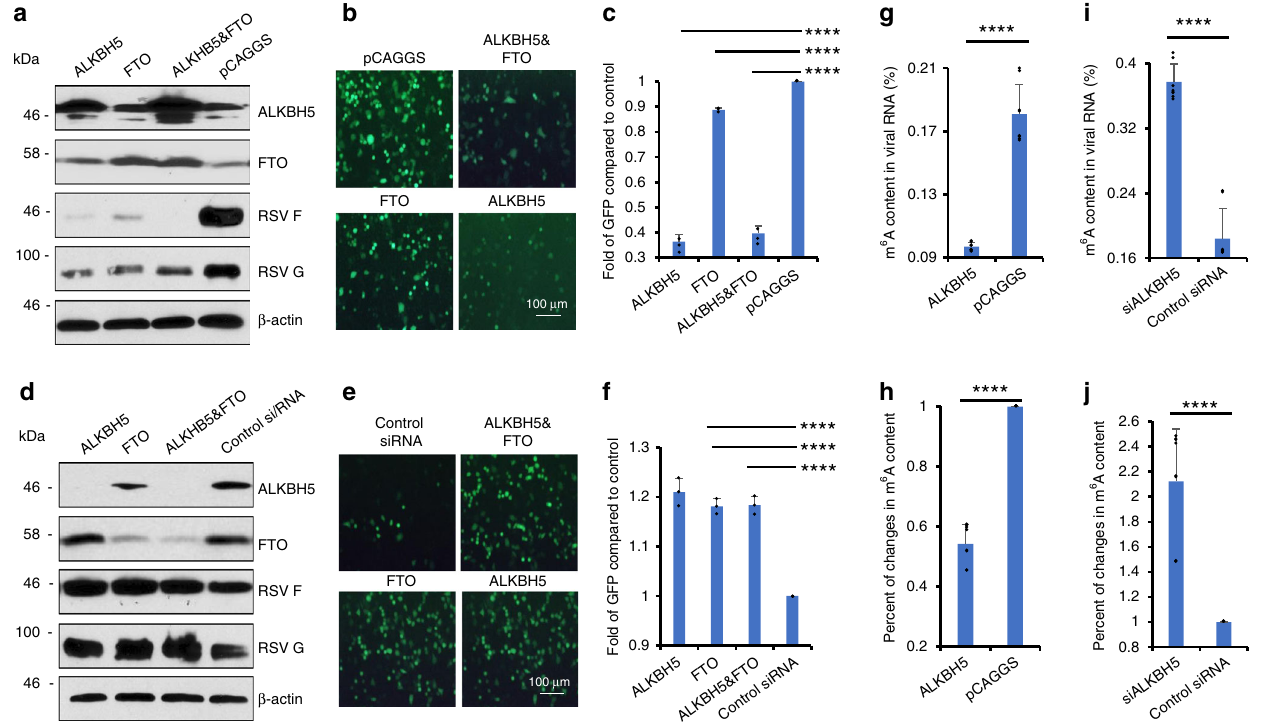
Fig. 5 Effects of m 6 A eraser proteins on RSV gene expression. a Overexpression of m 6 A eraser proteins diminishes RSV gene expression. HeLa cells were transfected with plasmids encoding ALKBH5 and/or FTO, followed by rgRSV infection at an MOI of 0.5. At 18 h post-infection, cell lysates were harvested for Western blot analysis. b Overexpression of m 6 A eraser proteins reduces GFP expression. The GFP expression was monitored by fl uorescence microscopy. Representative micrographs with 10 × magni fi cation (scale bar of 100 μ m) at 18 h post-infection were shown. c Quanti fi cation of GFP-positive cells by fl ow cytometry at 18 h post-infection. The P value (Student ’ s t-test) for ALKBH5, FTO, and ALKBH5&FTO is **** P = 1.91 × 10 − 6 , **** P = 1.34 × 10 − 5 , and **** P = 3.61 × 10 − 6 , respectively. d Knockdown of m 6 A eraser proteins enhances RSV gene expression. HeLa cells were transfected with siRNA targeting ALKBH5 and/or FTO, followed by rgRSV infection at an MOI of 0.5. At 18 h post-infection, cell lysates were harvested for Western blot analysis. e Knockdown of m 6 A eraser proteins enhances GFP expression. Micrographs with 10 × magni fi cation (scale bar of 100 μ m) are shown. f Quanti fi cation of GFP-positive cells by fl ow cytometry. Fold of GFP signal compared to the control is shown. Western blots and GFP images shown are representatives of three independent experiments. Flow cytometry data are expressed as mean ± standard deviation. The P value (Student ’ s t -test) for ALKBH5, FTO, and ALKBH5&FTO is **** P = 2.06 × 10 − 4 , **** P = 3.38 × 10 − 5 , and **** P = 6.50 × 10 − 6 , respectively. g Overexpression of m 6 A eraser protein reduces m 6 A level in viral RNA. A549 cells were transfected with plasmid encoding ALKBH5 or pCAGGS, followed by rgRSV infection. RSV particles were puri fi ed from supernatants. Virion RNA was subjected to m 6 A-IP. The P value (Student ’ s t -test) is **** P = 5.81 × 10 − 9 . h Fold reduction in m 6 A content in viral RNA compared to controls. The P value (Student ’ s t -test) is **** P = 1.17 × 10 − 11 . i Knockdown of m 6 A eraser protein increases m 6 A level in viral RNA. A549 cells were transfected with siRNA targeting ALKBH5 or control siRNA, followed by rgRSV infection. RSV particles were puri fi ed. Virion RNA was subjected